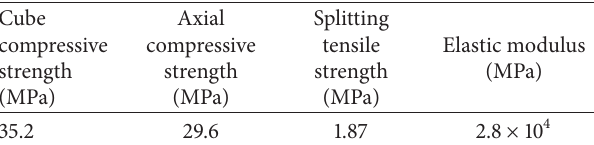
Table 1: Concrete parameter values.